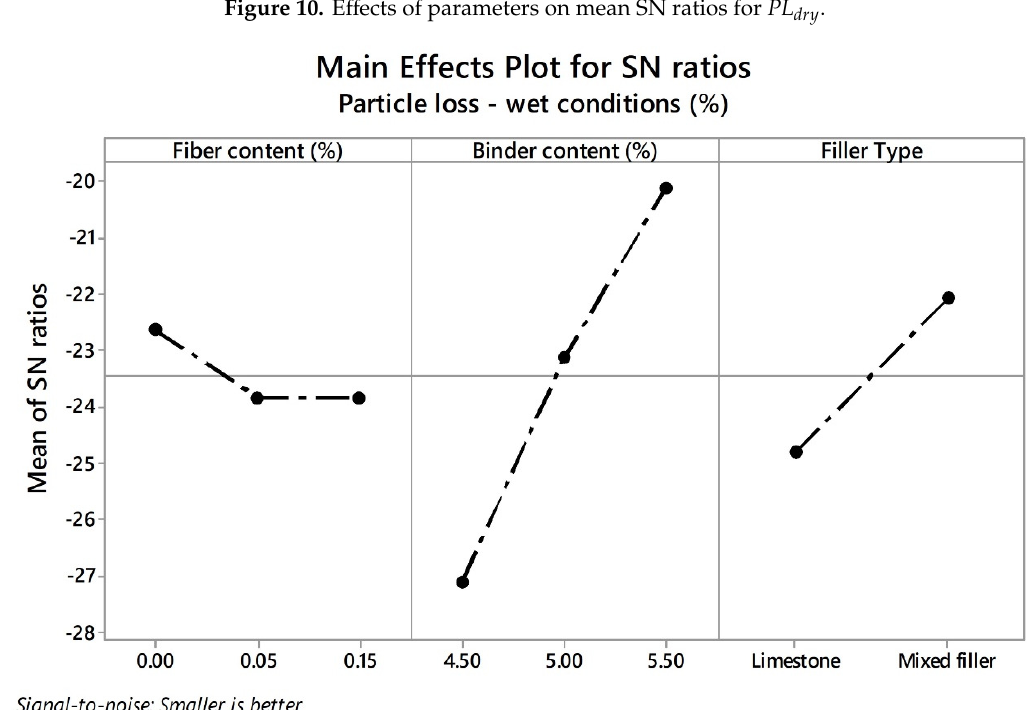
Figure 11. Effects of parameters on mean SN ratios for (cid:1842)(cid:1838) (cid:3050)(cid:3032)(cid:3047) . Figure 11. E ff ects of parameters on mean SN ratios for PL wet